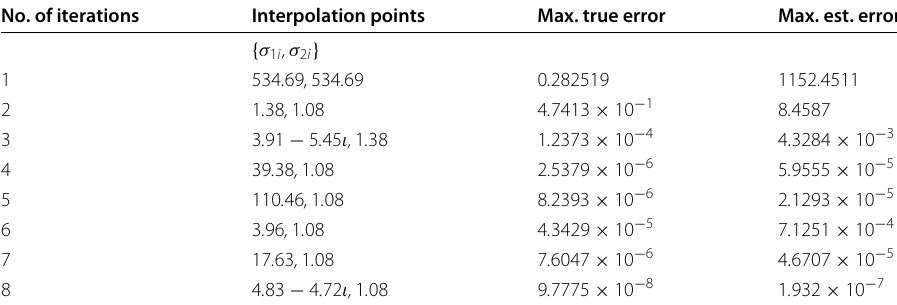
Table3 Error estimation results for the FitzHugh–Nagumo model No. of